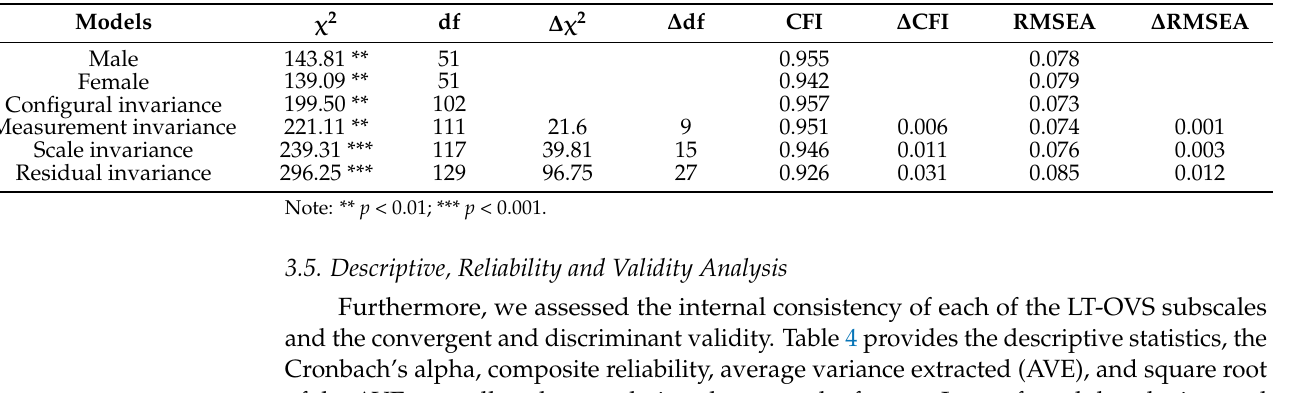
Table 3. Fit indices for the measurement invariance of the LT-OVS across gender.